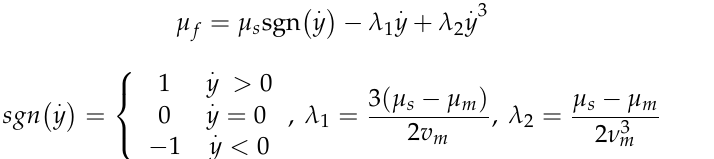
Figure 4. Piecewise nonlinear spring force of hot rolling mill rolls in the vertical direction.